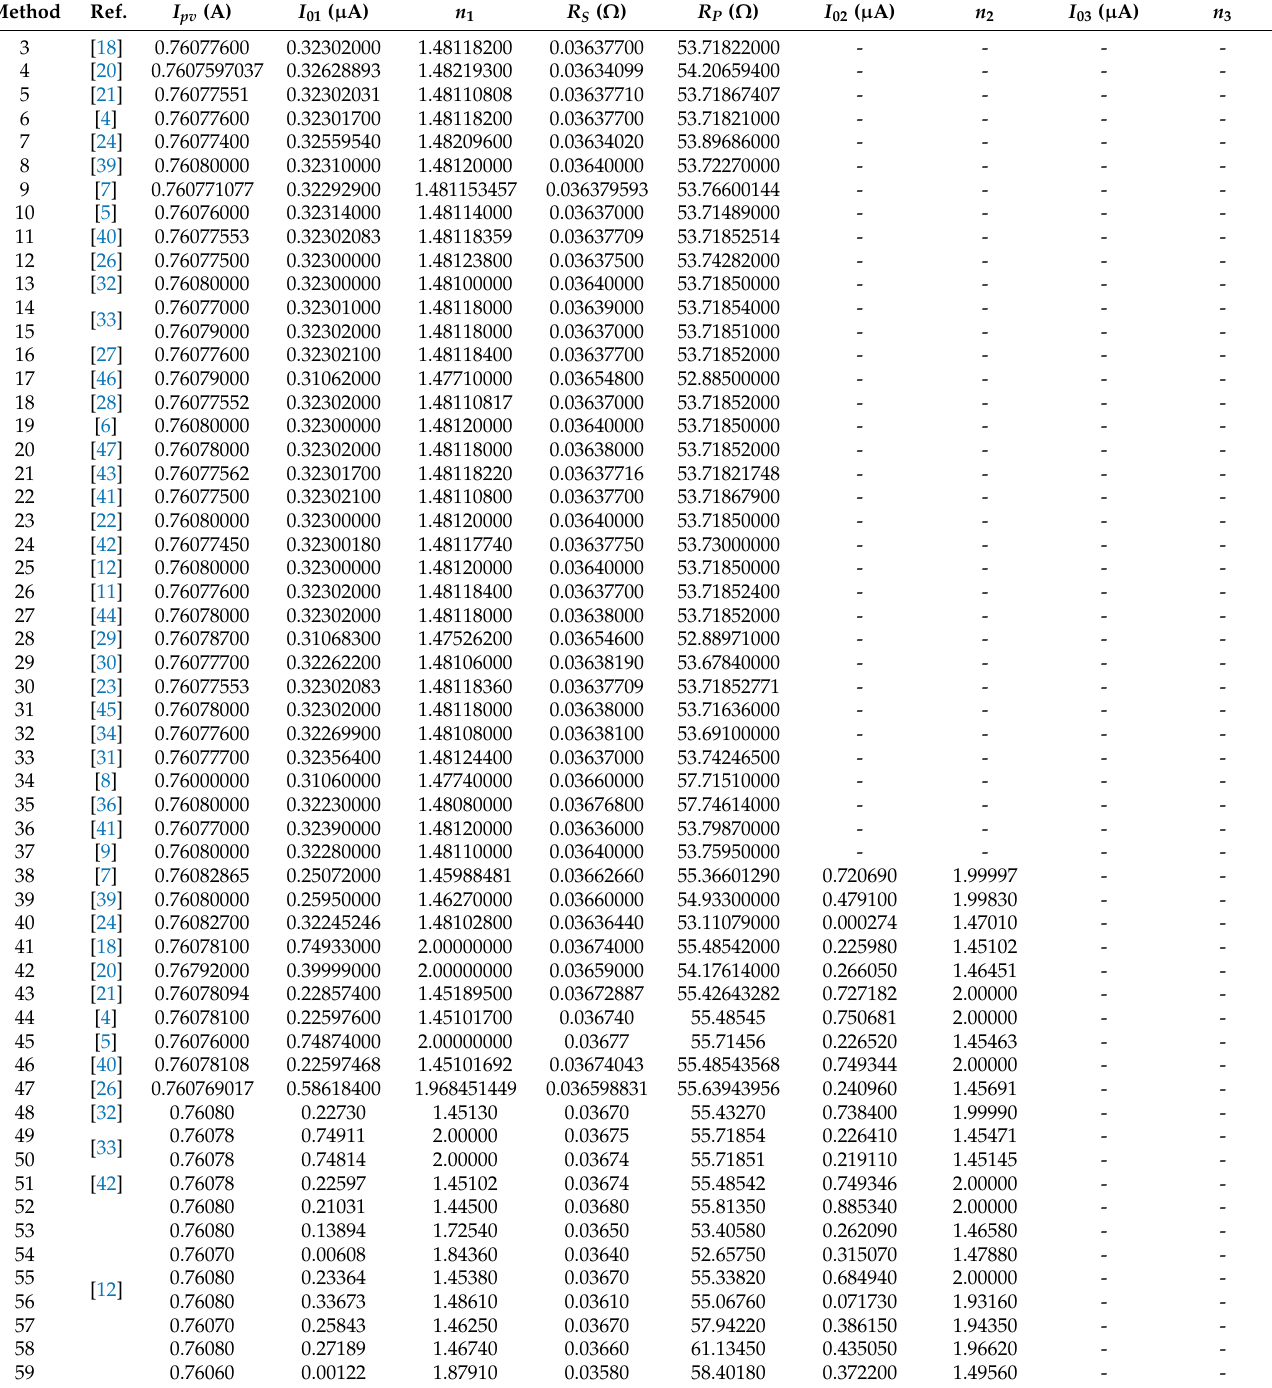
Table A1. Parameters of the solar RTC France cell obtained using the literature methods presented in Table